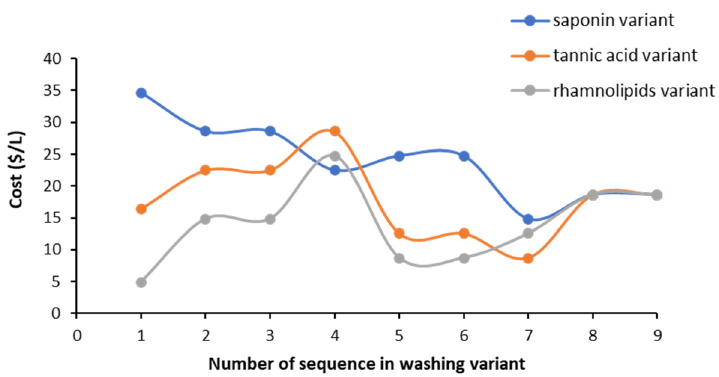
Figure 10. A cumulative relative cost of biosurfactant solutions used in triple washing with washing sequences from saponin, tannic acid and rhamnolipids variants (cost for 1 L of biosurfactant solution used in each washing step, m/V ratio 1/40).